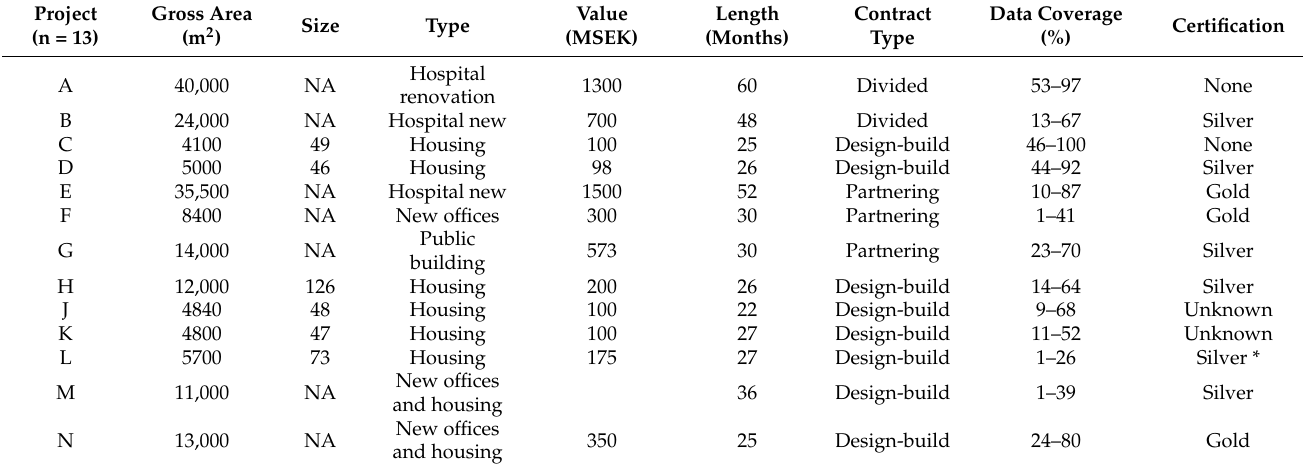
Table 1. Details of the 13 projects (* will not be officially certified but applying for silver certificate measures). Project (n =